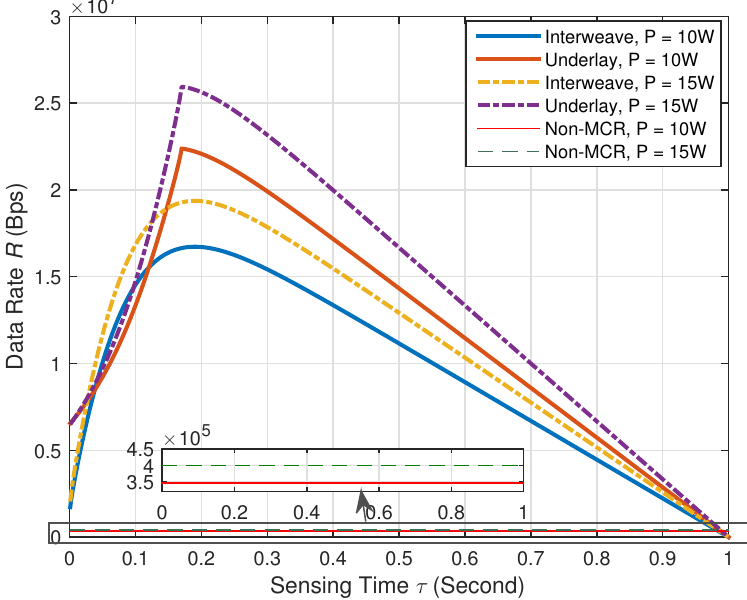
Figure 5. Sensing time versus data rate of the proposed methods in multiband-CR-enabled